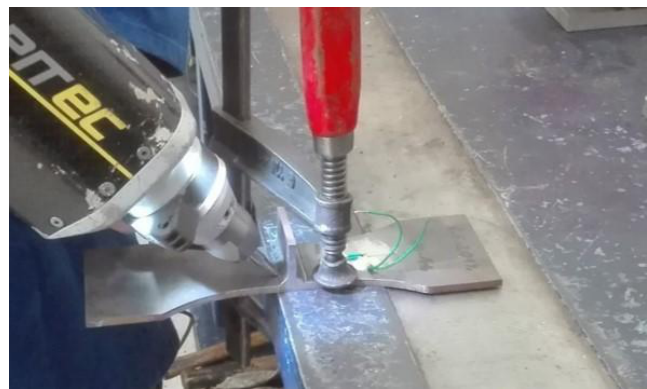
Figure 4. Clamping condition for HFMI-treatment.